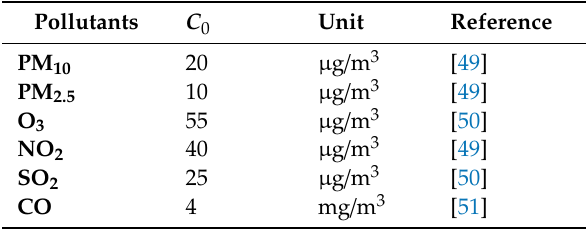
Table A1. Threshold concentration for ambient